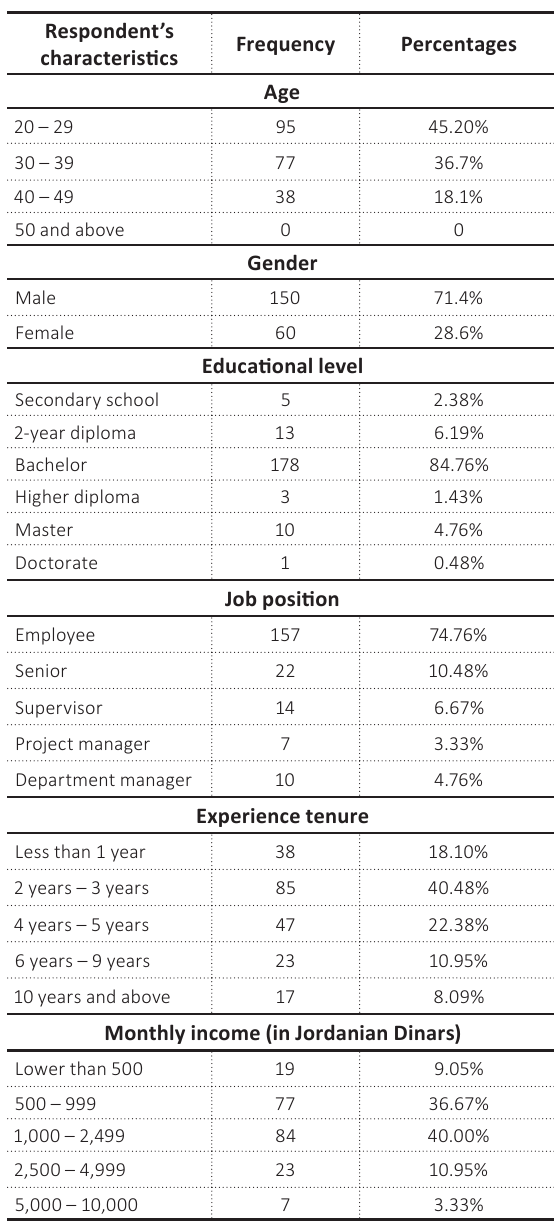
Table 1. Research respondents’